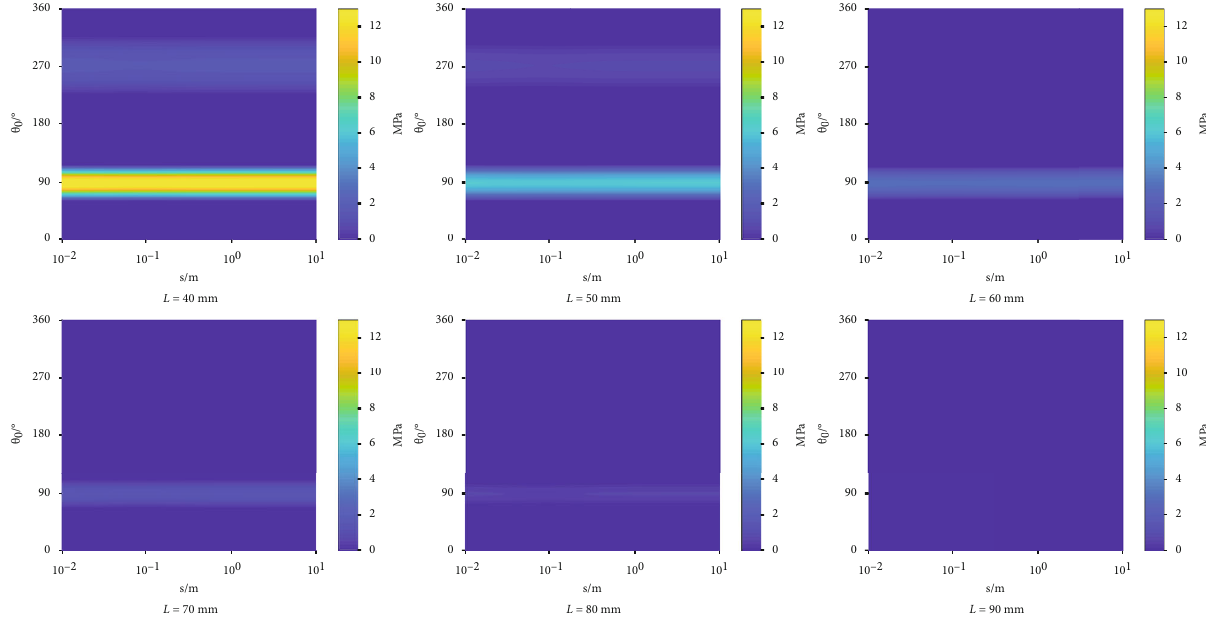
Figure 8: Maximum tensile stress increasing region with di ff erent depth di ff erences.